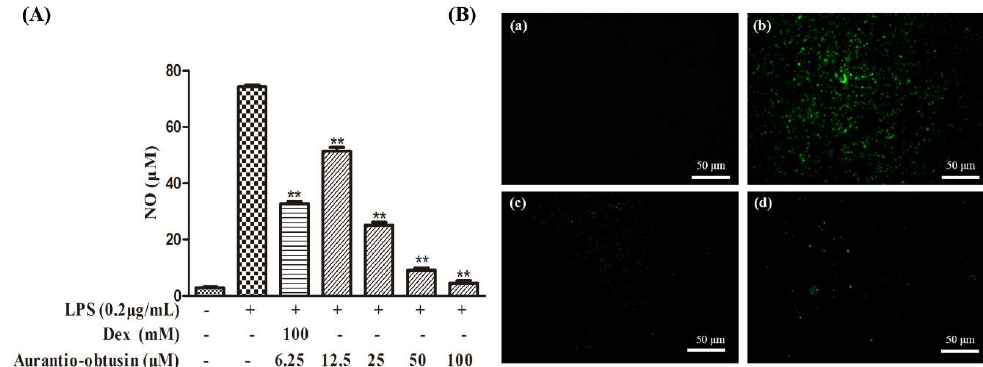
Figure 3. Effect of aurantio-obtusin on nitric oxide (NO) production in lipopolysaccharide (LPS)- activated RAW264.7 cells. ( A ) The RAW264.7 cells were treated with various concentrations (6.25–50 μM) of aurantio-obtusin for 2 h and then incubated with LPS (0.2 μg/mL) for 24 h. Data are presented as mean ± SD ( n = 6). ** p < 0.01 represent significance when compared to LPS-only treated cells. ( B ) RAW264.7 cells were incubated with the indicated concentrations of aurantio-obtusin and 0.2 μg/mL LPS for 24 h. Intracellular NO production was evaluated with DAF-FM diacetate by laser scanning microscopy; (a) control (cells alone); (b) cells stimulated with LPS; (c) aurantio-obtusin (50 μM) was added under the condition of part (b); (d) 100 μM dexamethasone was added under the condition of part (b).